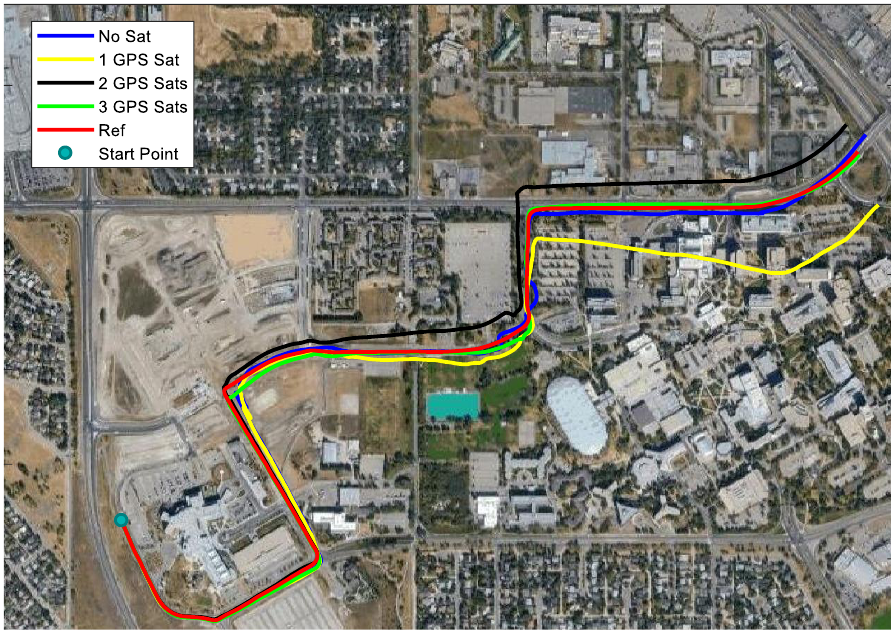
Figure 4. Trajectories using different numbers of GPS satellites.